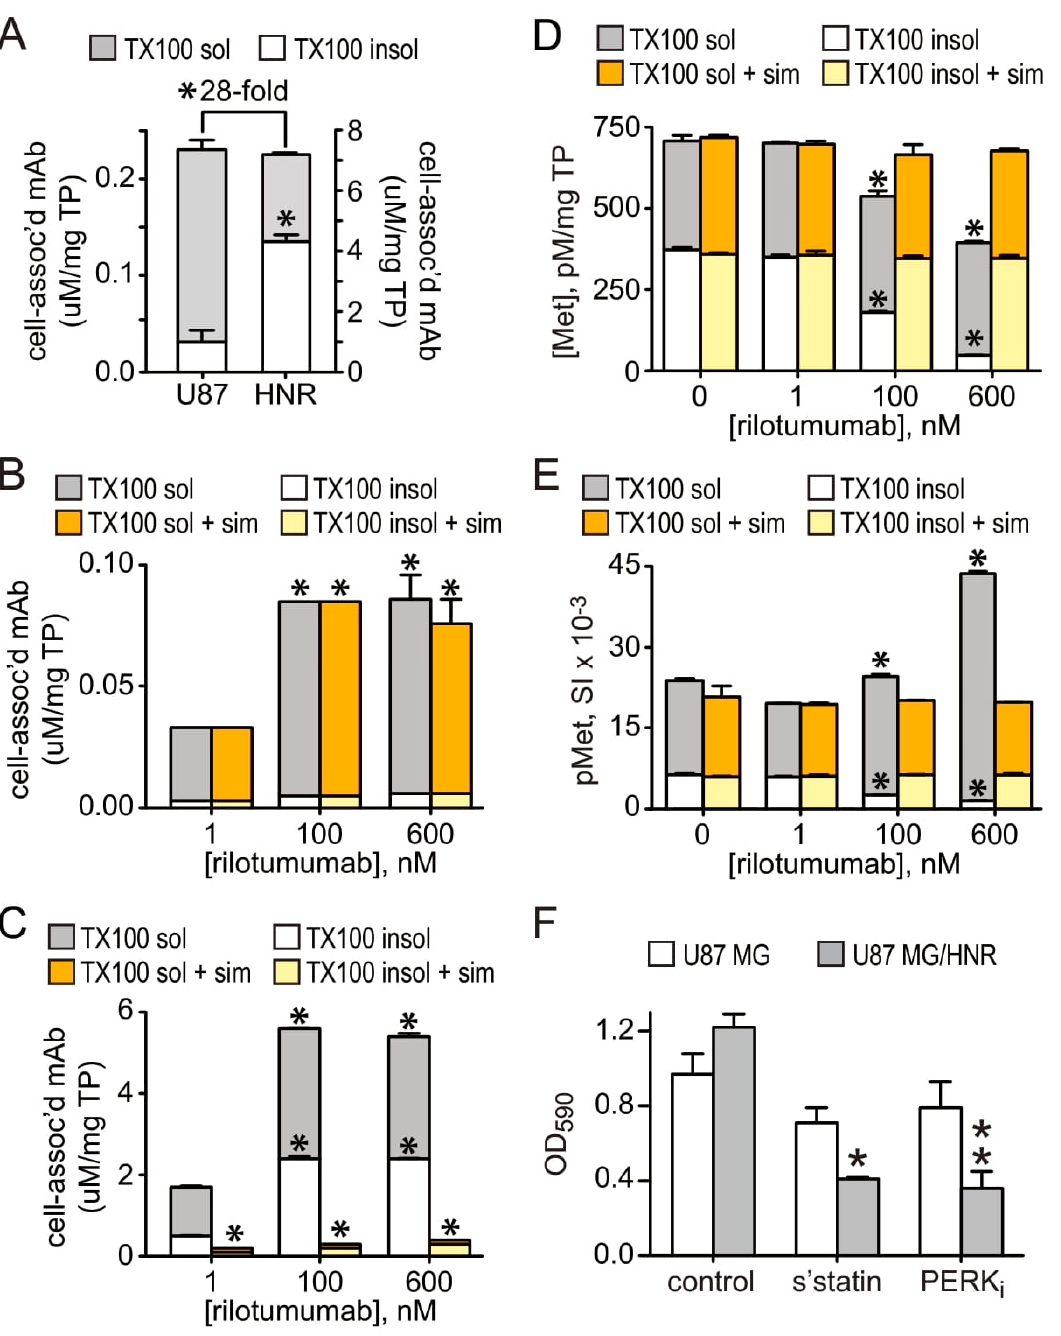
Figure 9. Qualitative and quantitative changes in vesicular trafficking accompany rilotumumab resistance. As in Figure 8, cells were extracted with ice-cold buffer containing TX-100 detergent, protease and phosphatase inhibitors before centrifugation to separate soluble (“sup”, left, or “super” right) and insoluble (“pel”, left, or “pellet”, right) cell fractions; insoluble fractions were subse- quently solubilized in buffer containing 1% SDS prior immunoassay analysis (see Methods). ( A ) Cell-associated mAb (mean uM rilotumumab/mg total protein ± SD, n = 3) measured in U87 MG (“U87”, left y -axis) or U87 MG/HNR (“HNR”, right y -axis) cell Triton X-100 extracts separated into soluble (gray bars) and insoluble (white bars) fractions prepared after 24 h rilotumumab exposure. ( B , C ): Cell-associated mAb (mean uM rilotumumab/mg total protein ± SD, n = 3) in Triton X-100 soluble (gray or orange bars) and insoluble (white or yellow bars) fractions prepared from U87 MG cells ( B ) or U87 MG/HNR cells ( C ) exposed for 16 h to rilotumumab at the indicated